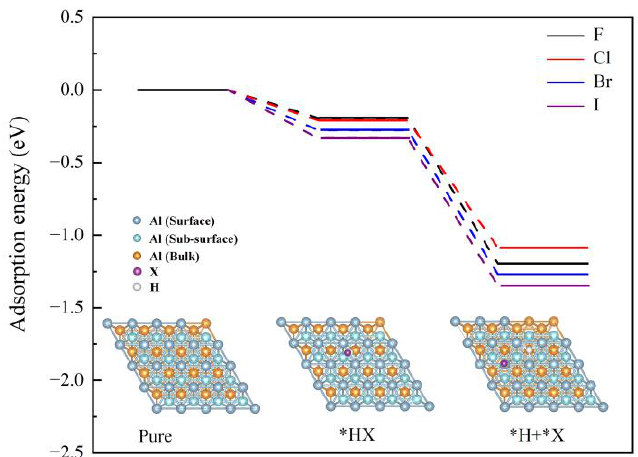
Figure 7. The adsorption energy potential profiles of HX cleavage on the Al (111) surface. Table 6. Calculated adsorption energies of *H + *X on Al (111) surface (E ads ), the bond length between halogen and Al atoms (d), and the charge transfer from Al (111) to halogen ions. Model E ads d Atomic Charge eV Å e *H + *F − 1.195 1.707 0.850